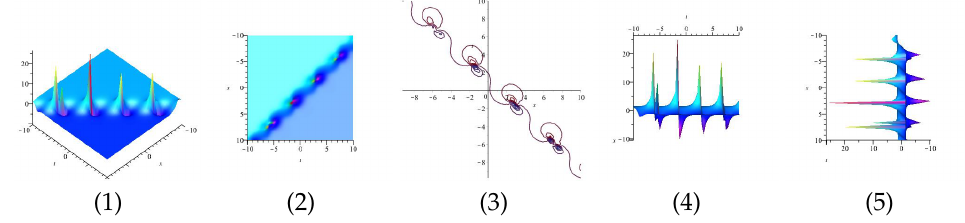
Figure 12. The 3D and 2D with the diagram of the imaginary part of equation u 2 ( x , t )